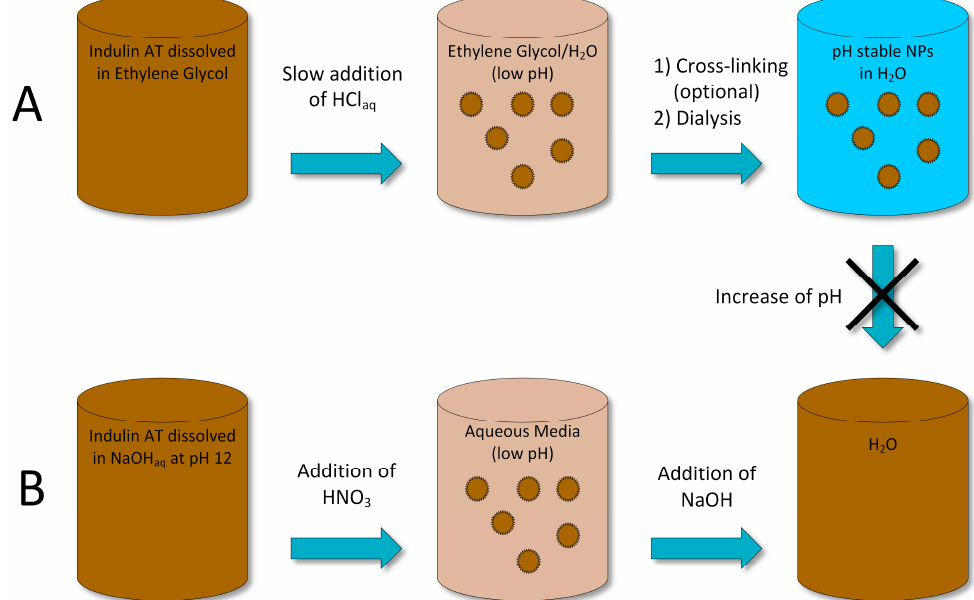
Figure 5. Schematic illustration of the two different precipitation methods. The canceled arrow between method ( A ) and ( B ) indicates the stability of particles at increased pH value produced with method ( A ). Precipitation of ethylene glycol lignin solution with HCl and following optional crosslinking and dialysis. ( B ) Precipitation of lignin from aqueous NaOH solution at pH 12 by dropping the pH value with HNO 3 . Adapted from Frangville et al. [16]